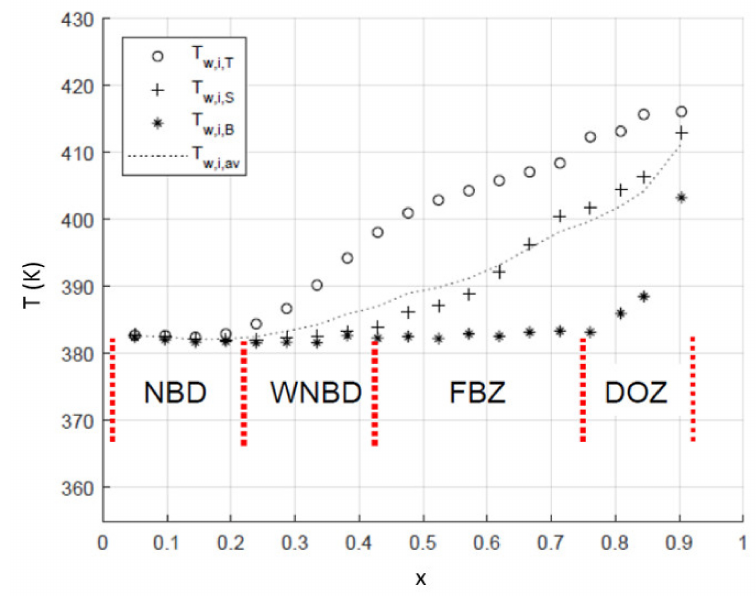
Figure 5. Inner wall temperatures and the division of the observed heat transfer mechanisms.